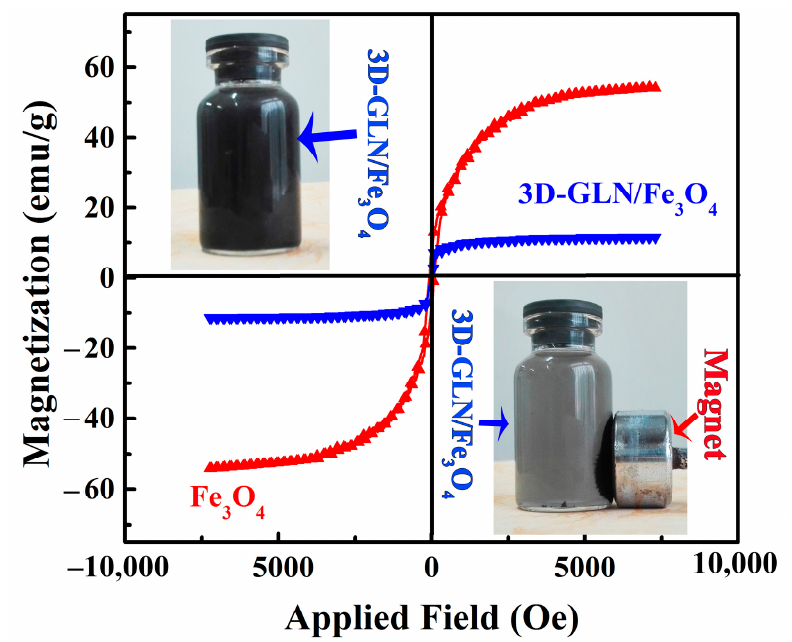
Figure 6. Magnetization curves of pure Fe 3 O 4 and 3D-GLN/Fe 3 O 4 at ambient temperature.